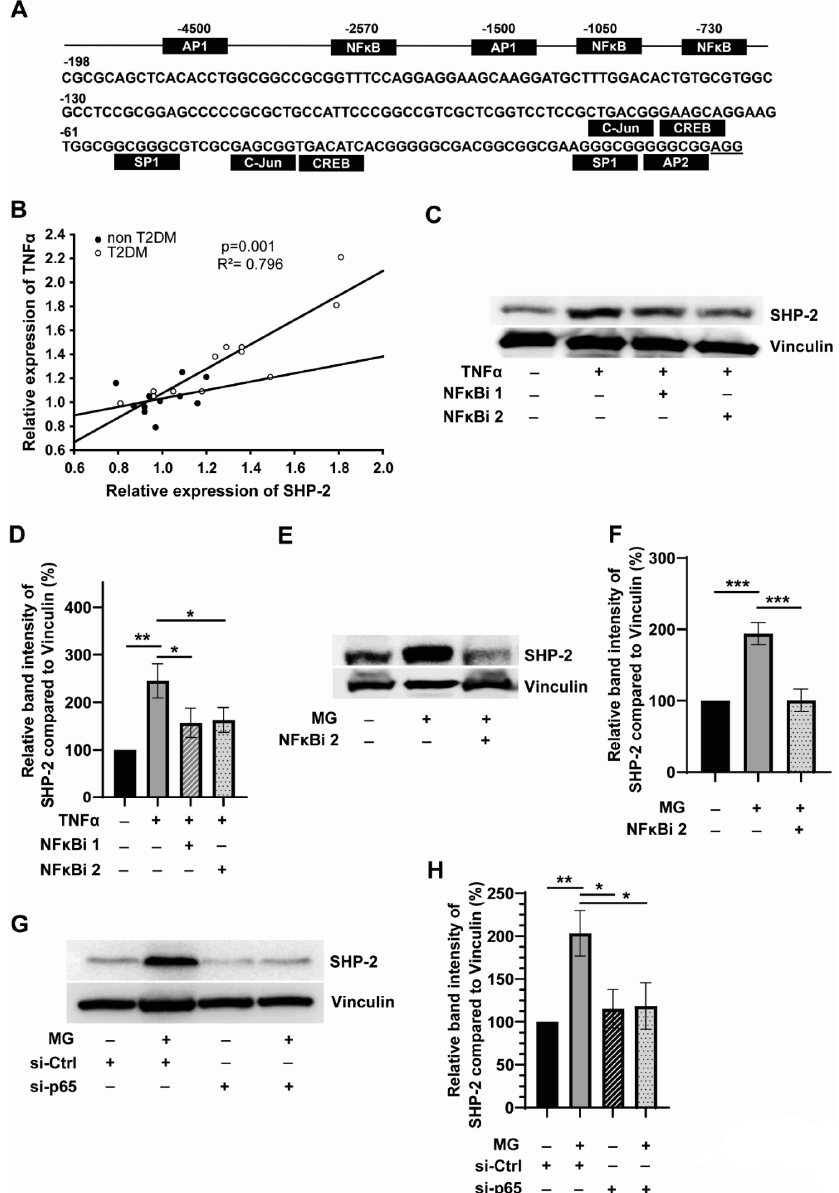
Figure 2. SHP-2 expression is linked to inflammation and is regulated by NFkB in monocytes. ( A ) The promoter region of the PTPN11 (SHP-2) gene depicting the binding sites of various tran- scription factors, including the three NFkB binding sites ( B ) Linear regression analysis of SHP-2 and TNF α transcript levels in non-T2DM ( n = 12) and T2DM ( n = 12). ( C ) Representative blots and ( D ) corresponding quantification. Expression of SHP-2 in relation to Vinculin. Exposure of monocytes without (black bar) or with (grey bars) 10 µ g/mL TNFa. Quantification of monocytes additionally treated with NFkB-inhibitor is shown as striped (1 µ M NF-kB Activation Inhibitor I, NF κ Bi 1, Calbiochem) and dotted bar (5 µ M Activation Inhibitor II, JSH23, NF κ Bi 2, Calbiochem). n = 6. ( E ) Representative blots and ( F ) corresponding quantification. Expression of SHP-2 in relation to Vinculin. Exposure of monocytes without (black bar) or with (grey bars) 300 µ M MG for 24 h. Quantification of monocytes additionally treated with NFkB-inhibitor is shown as the dotted bar (5 µ M Activation Inhibitor II, JSH23, NF κ Bi 2). n = 6. ( G ) Representative blots and ( H ) corresponding quantification. Expression of SHP-2 in relation to Vinculin. Exposure of Monocytes without (black bar) or with (grey bars) 300 µ M MG for 24 h. Striped and dotted bars indicate monocytes which were additionally transfected with siRNA against NFkB-p65. n = 5. * p < 0,05, ** p < 0.01, *** p <